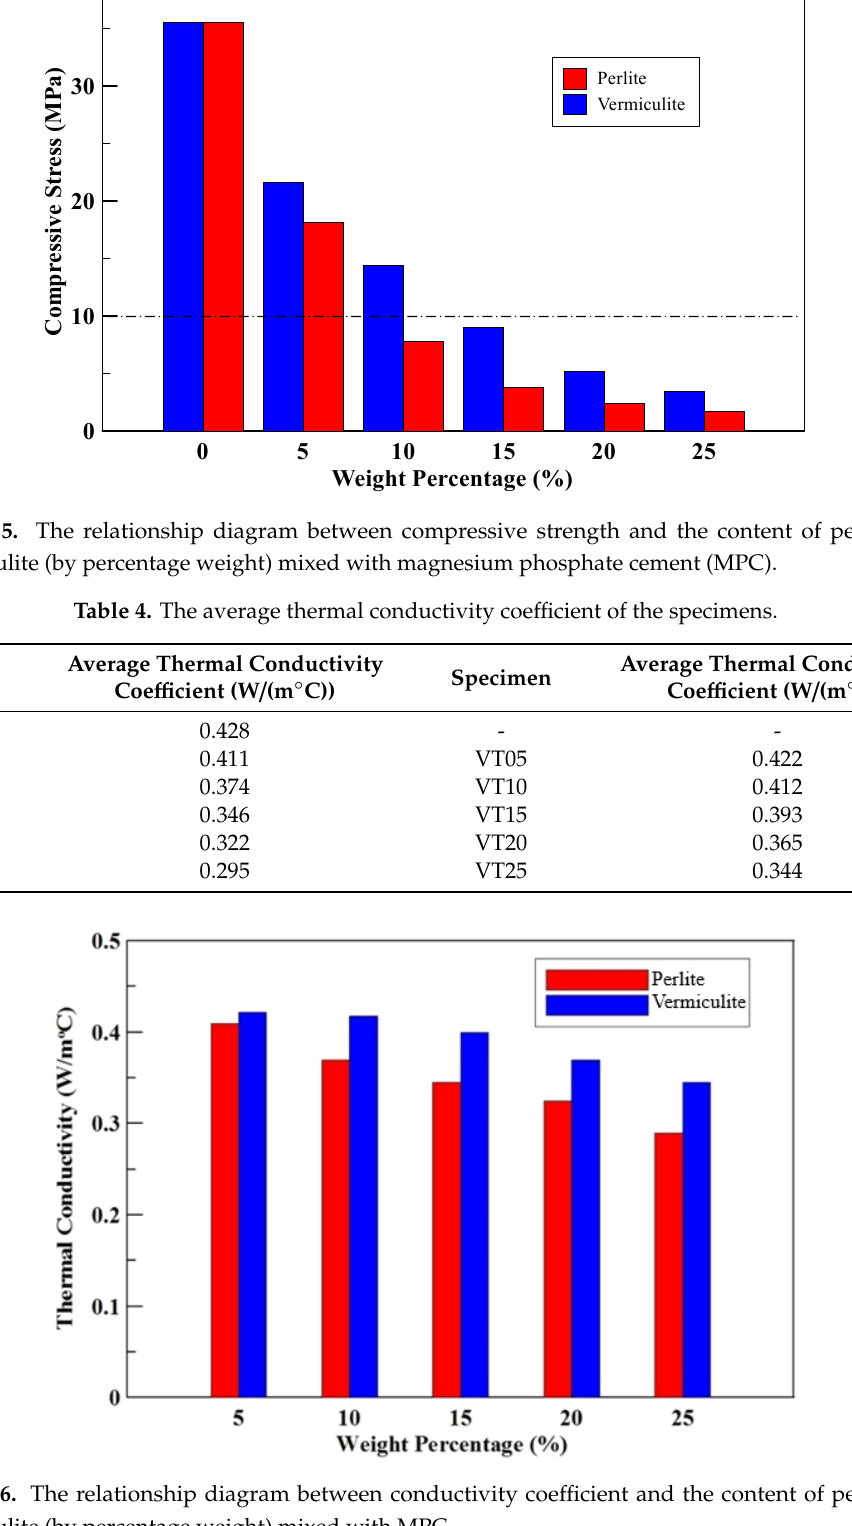
Figure 6. The relationship diagram between conductivity coefficient and the content of perlite or vermiculite (by percentage weight) mixed with vermiculite (by percentage weight) mixed with MPC.